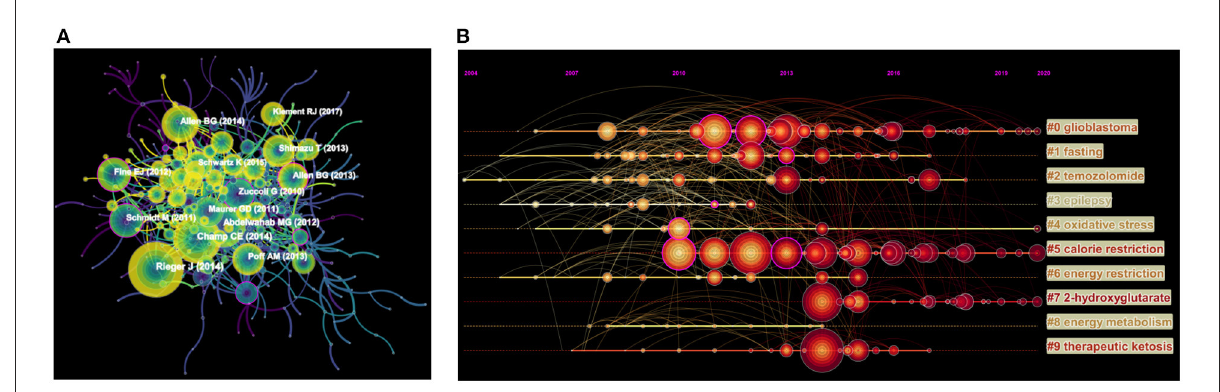
FIGURE5 (A) Network visualization map of cited-references in the field of KD on cancer research. The nodes represent cited-references, and the lines between the nodes represent cited-references relationships. (B) Timeline view of co-cited references in the field of KD on cancer research. The cluster with warmer color and larger nodes contained more publications, indicating that this clustering issue was the hotspot in this field.